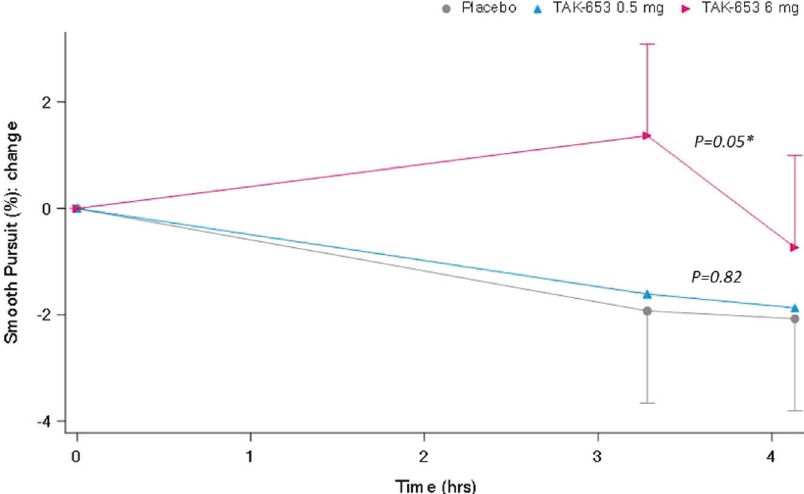
Fig. 3 Smooth pursuit eye movements. Smooth pursuit eye movements: change from baseline time effect pro fi le of the least square (LS) mean